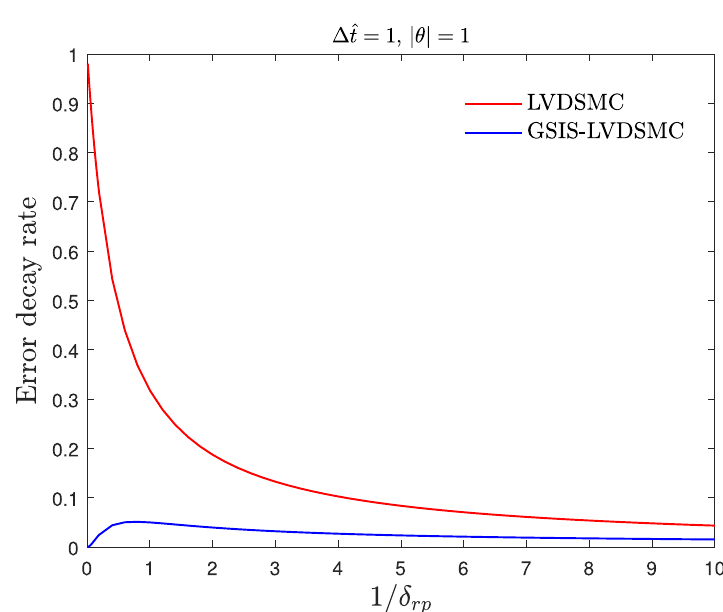
Fig. 2 The error decay rate as a function of the Knudsen number ( 1 /δ rp ) for LVDSMC and